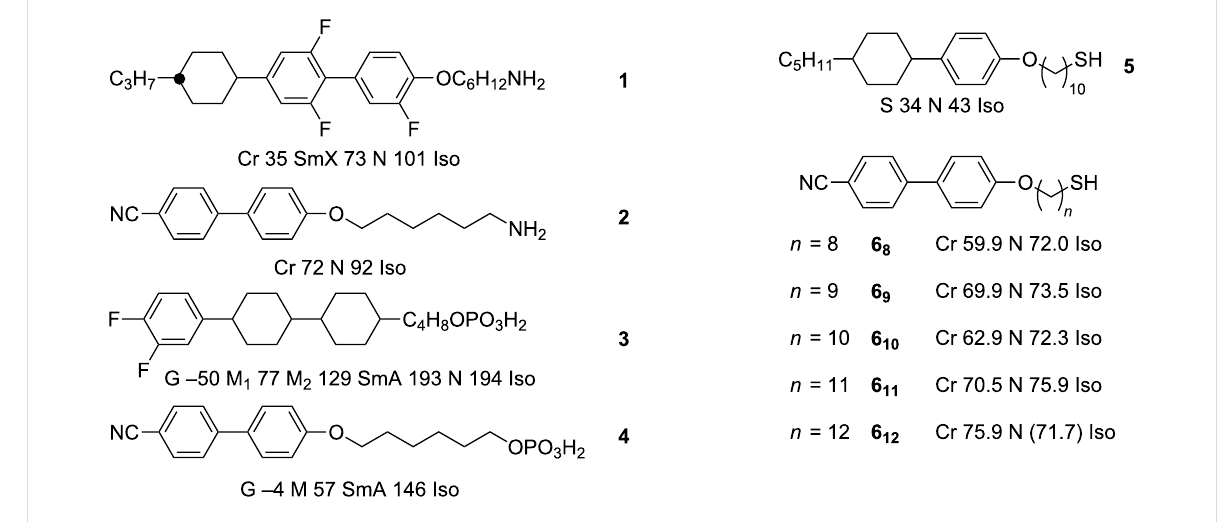
Figure 3: Chemical structures and LC properties of the rodlike ligands discussed in the text.